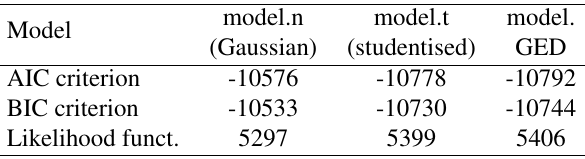
Table 1. AIC, BIC and likelihood function for various types error distribution (model (6)).